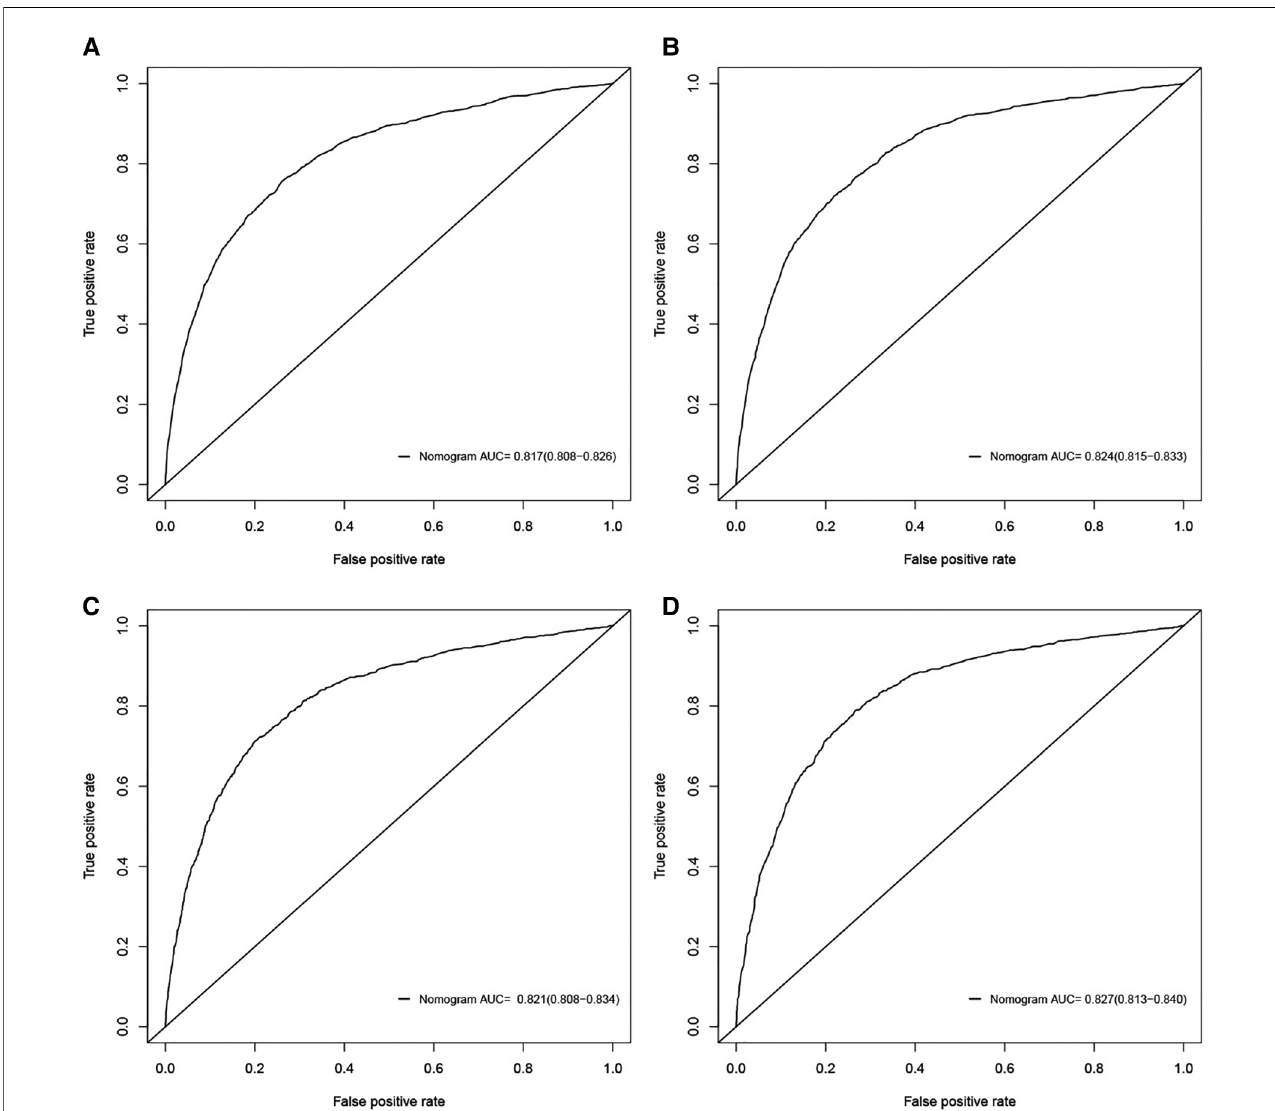
FIGURE 2 ROC curves for the nomograms in predicting all-cause and cancer-speci fi c early death in the training cohort ( A,B ) and the validation cohort ( C,D